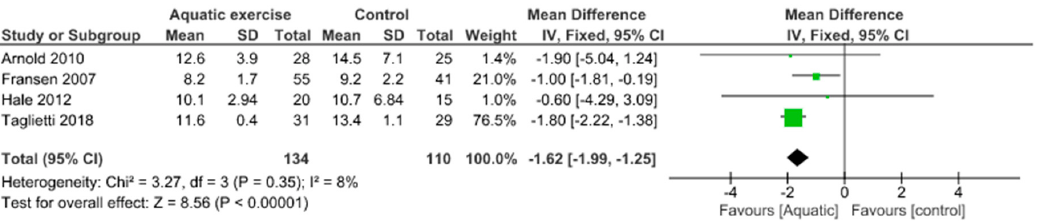
(cid:76)(cid:76)(cid:76) (cid:35) moderate